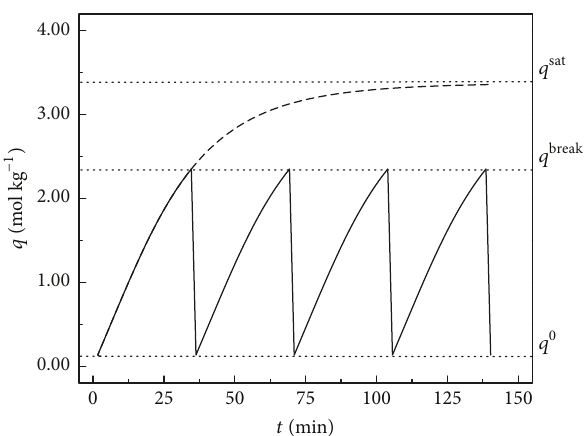
Figure 3: Concentration of impurity in the solid phase in an adsorbent column with cyclic